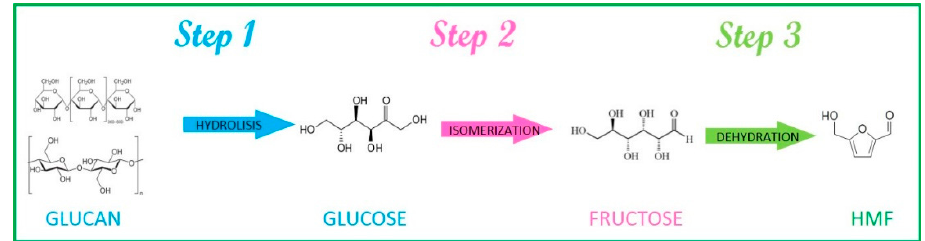
Figure 2. Schemes of the reaction steps from glucan to HMF.